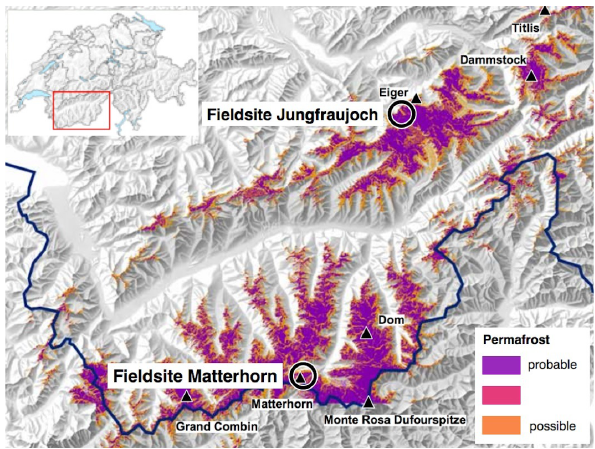
Fig. 3. Overview of the Jungfraujoch field site around the Phinx obervatory. The circles with labels indicate the sensor locations. All pictures taken in October 2006.